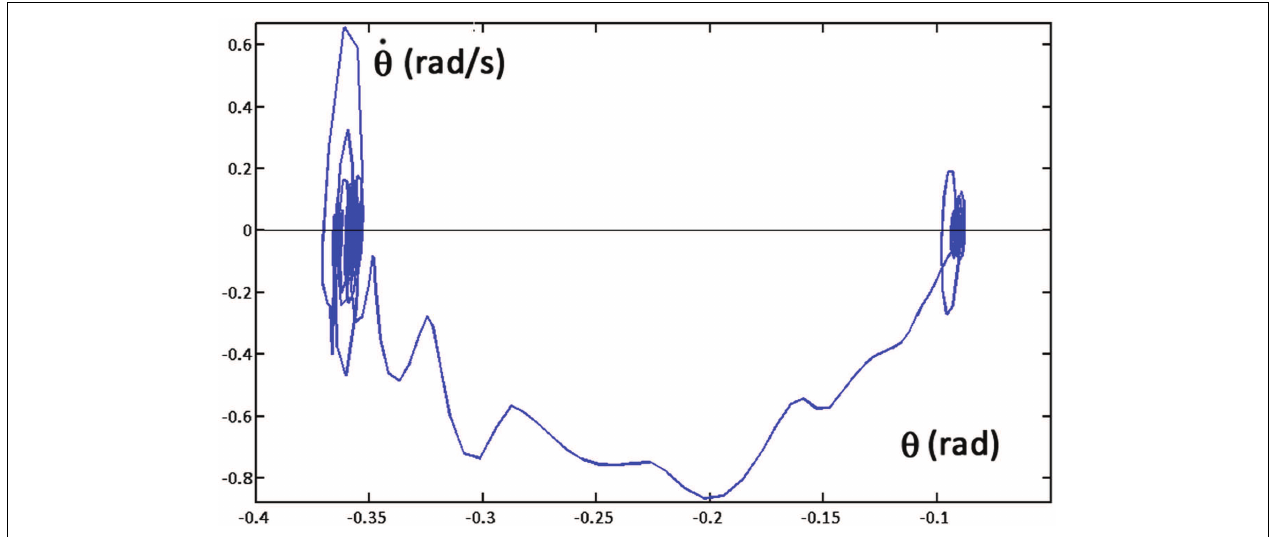
FIGURE 7 | Sway movements generated by the PeterPan simulation package during a whole-body reaching movement: sway angle θ vs. sway speed d θ /dt .The initial posture (tilted forward 0.1rad) corresponds to the oscillations on the right part of the graph; the final posture (tilted forward 0.37rad) to the oscillations on the left part of the graph.The ragged curve corresponds to the shift from the initial equilibrium to the final equilibrium